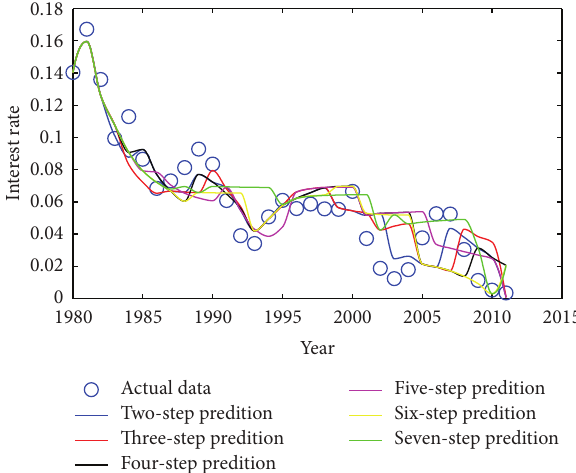
Figure 2: The actual investment versus estimated investment.